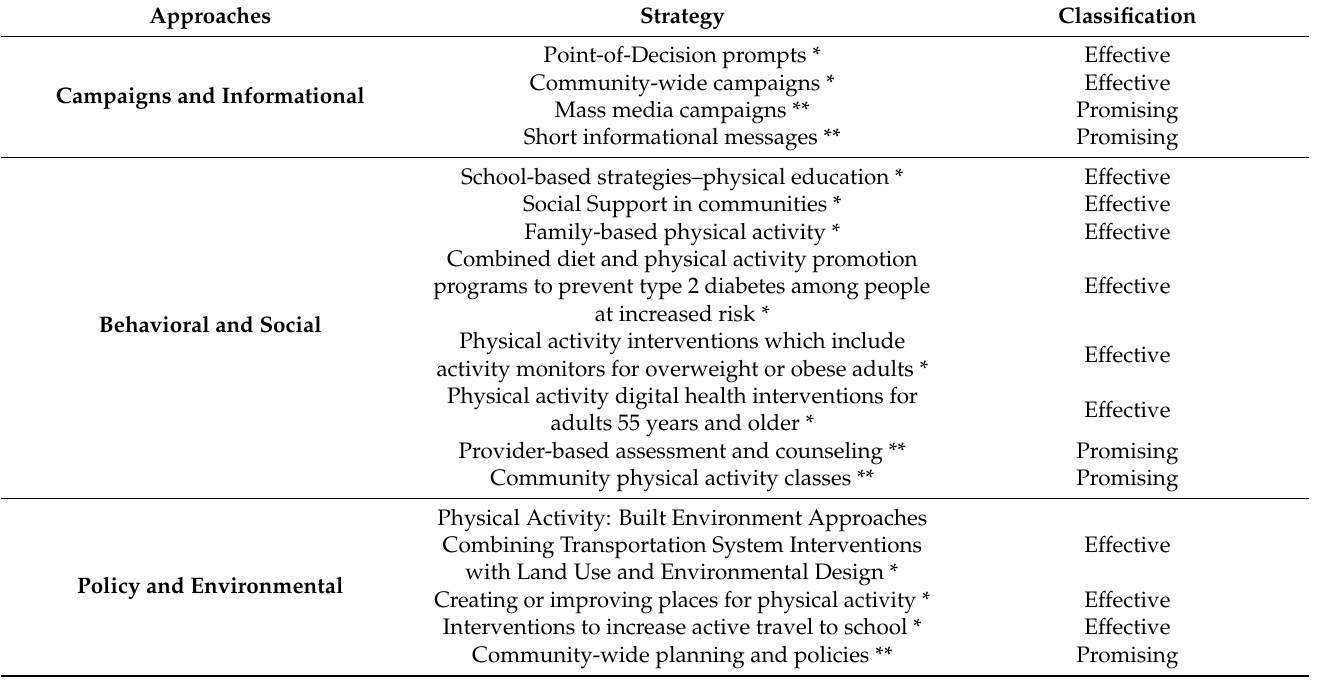
Table 3. Overview of strategies to promote physical activity in